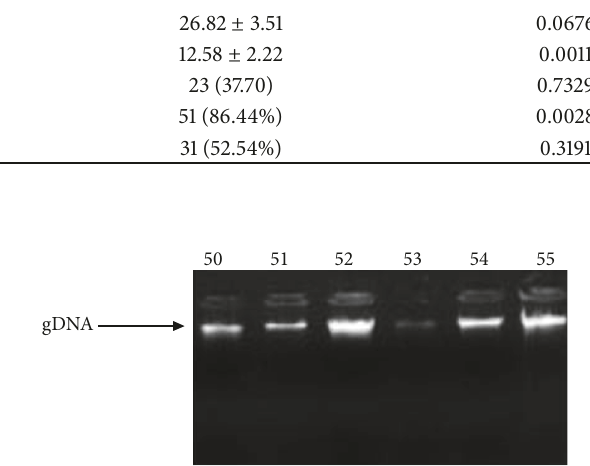
Figure 1: Agarose gel Electrophoregram of genomic DNA extracted from participants’ blood by the salting out method. Numbers represent participants’ codes.